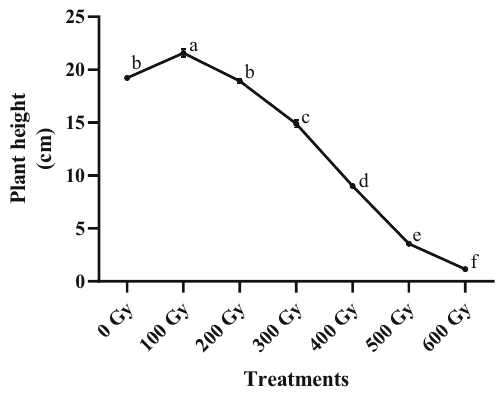
Figure 2: Survival percentage of irradiated wheat var. CIRNO C2008 seeds. Di ff erent letters indicate a signi fi cant di ff erence ( Tukey HSD p < 0.05 ) .